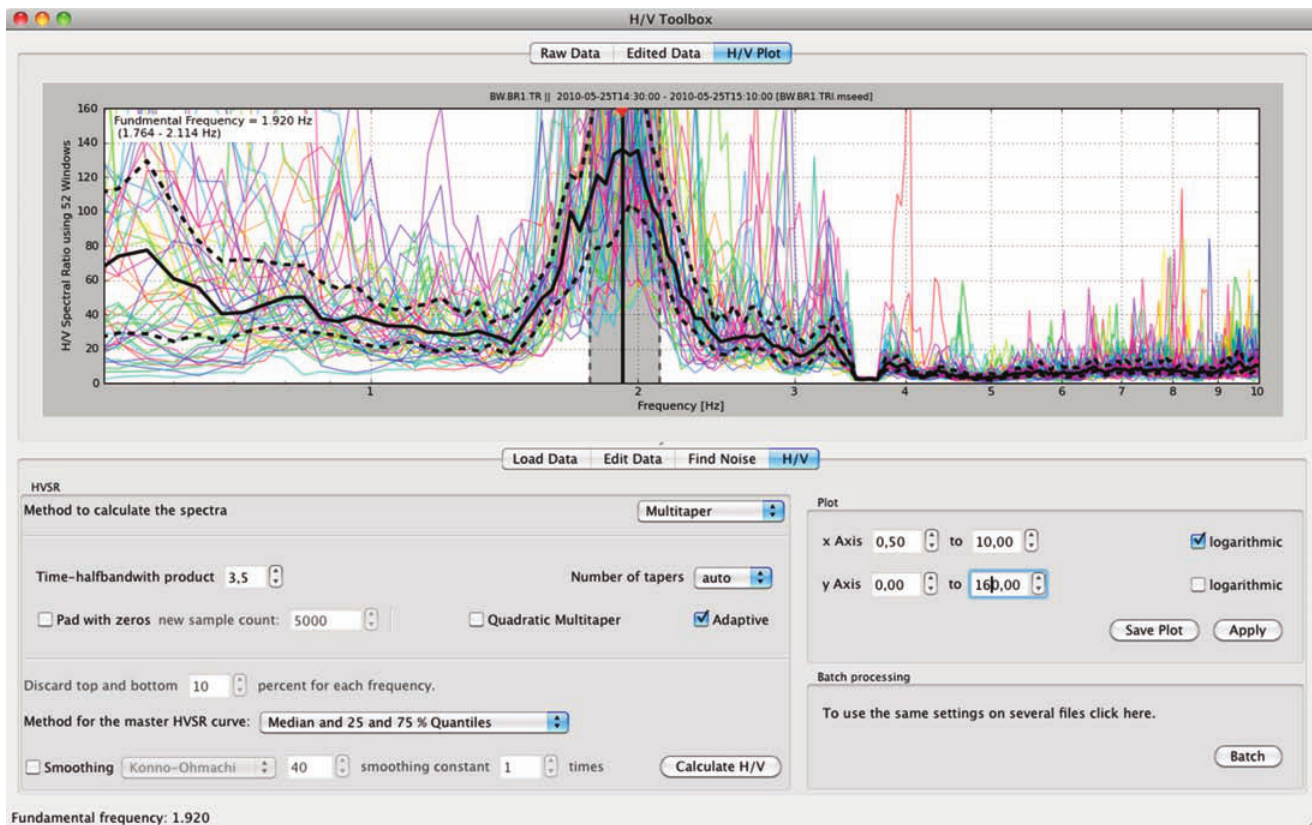
Figure 12. Screenshot: The H/V Toolbox displaying the results of an analysis run.